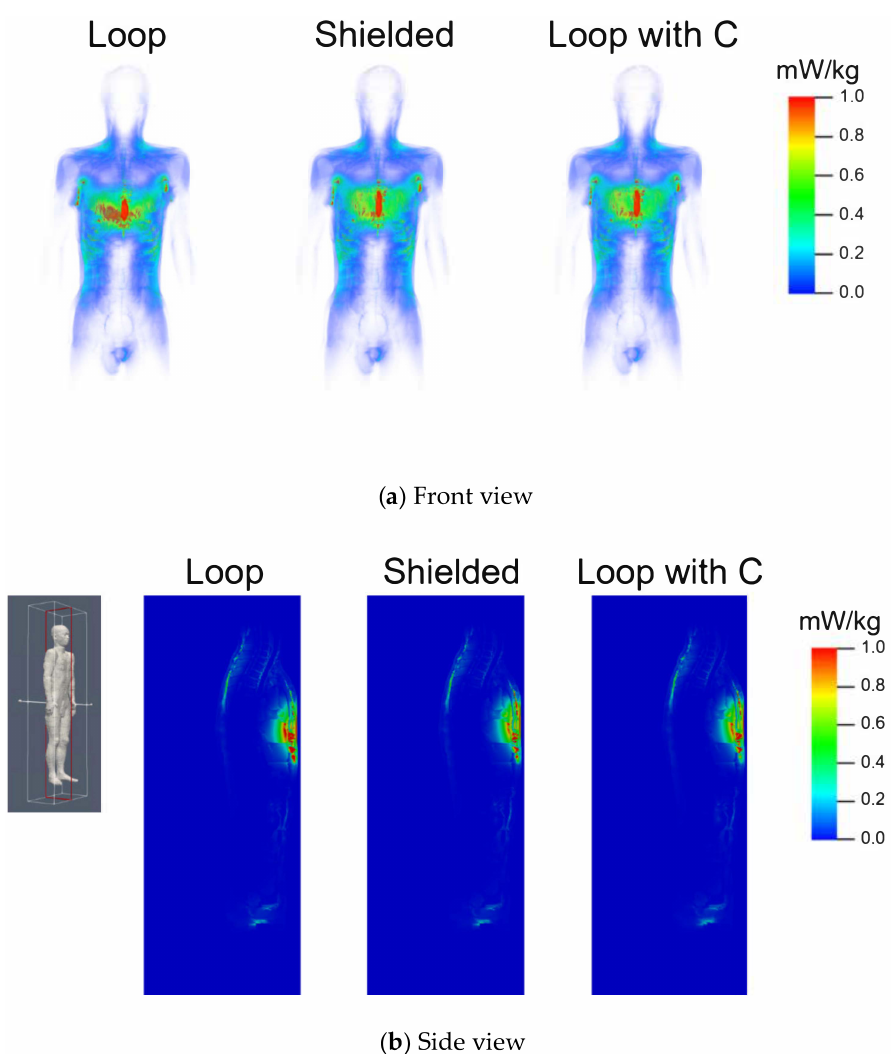
Figure 8. Local SAR (Specific Absorption Rate) distribution in the human